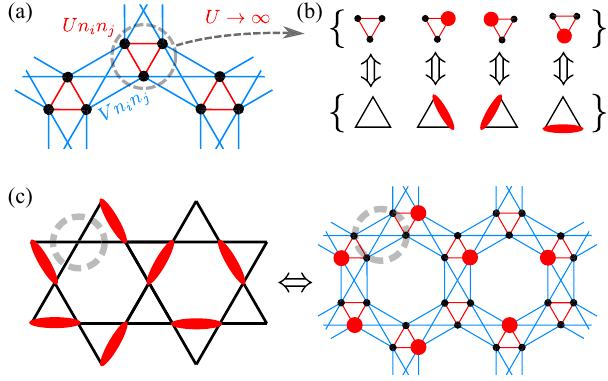
FIG. 10. Spin- 1 = 2 model on the ruby lattice, which gives the effective spin- 3 = 2 model on the honeycomb lattice. In panel (a), the black dots denote spin- 1 = 2 ’ s on the ruby lattice. We have n density-density repulsion ( n ¼ ð 1 þ σ z = 2 Þ ) with strength Un i j n on the red bonds and Vn on the blue bonds. In panel (b), if i j U → þ ∞ , each triangle of the ruby lattice becomes an effective four-state system. We show how this corresponds to an emergent dimer model Hilbert space on the kagom´e lattice, i.e., the spin- 3 = 2 Hilbert space on the honeycomb lattice introduced in Sec. II. In the main text, we discuss how the spin- 1 = 2 Hamiltonian leads to our parent model in Eq. (15). (c) Example of how a kagom´e dimer state is mapped to a spin- 1 = 2 (or hardcore boson) configuration on the ruby lattice. Violations of the dimer constraint correspond to rectangles with no (or two) hardcore